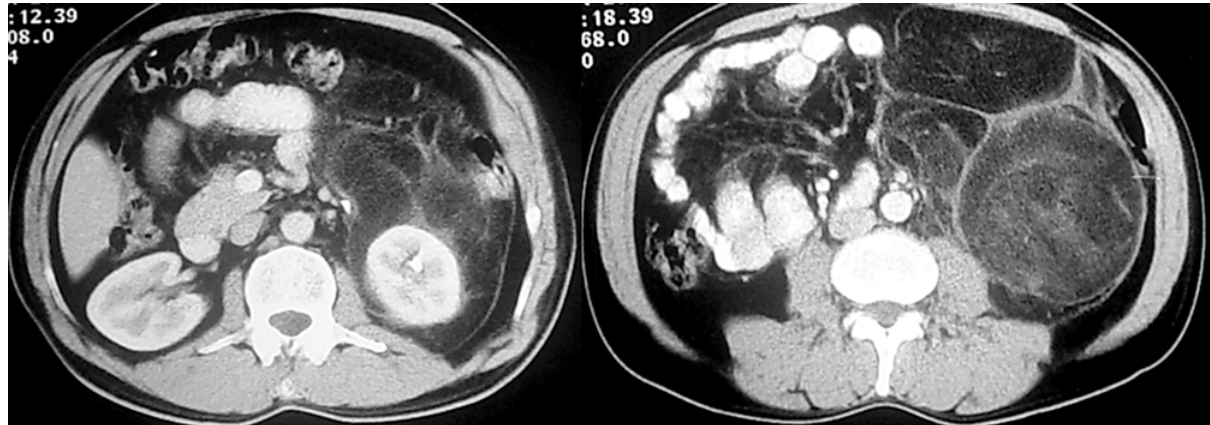
Figure 1 – Large perinephric tumor with fat attenuation surrounding the left kidney (Case-1).